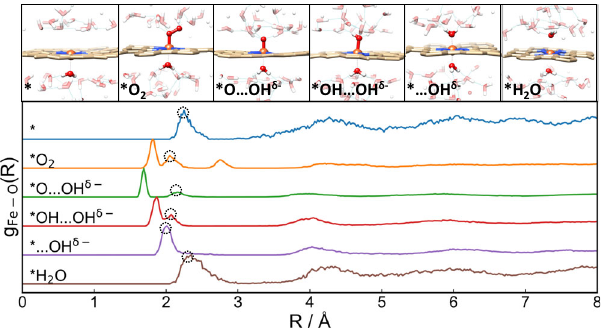
Fig. 5 The distribution of the backside axial water. The radial distribution function g ( r ) for the investigated reaction intermediates with their representative AIMD snapshots labeled on